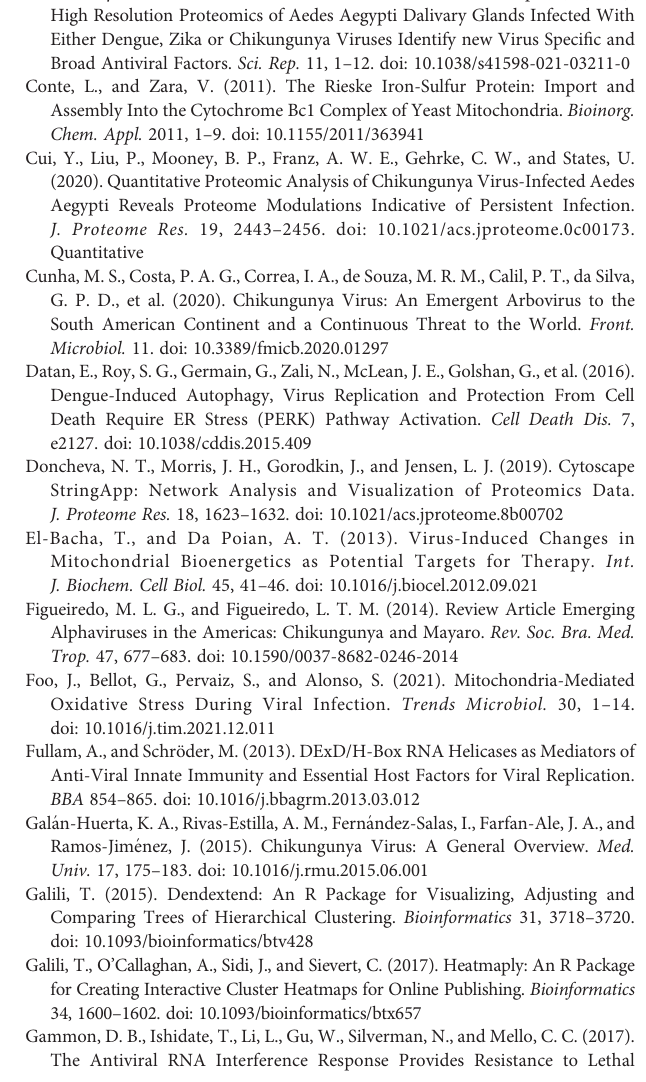
isolates. Vero cells are fi xed in culture and produce an extracellular matrix that is degraded after cell death. Then, cells become rounded. Supplementary Figure 2 | Quality control of protein group identi fi cation and quanti fi cation. (A) Boxplot of log 2 protein group abundances. (B) Histogram of log 2 protein groups abundances. (C) Number of valid values according to the number of replicates, cut-off of three replicates was used in this analysis, represented by the dashed line. (D) fi lter for ANOVA and g-test analysis, only ANOVA fi lter was used, set by two replicates per group, represented by the dashed line. (E) robust Mahalanobis distance analysis considering Correlation, median absolute deviation, skewness and proportion of missing values, suggesting the absence of extreme outliers (p-value = 1e-04). (F) probabilistic principal component analysis of protein group abundances according to each replicate. Supplementary Figure 3 | Bubble plot of enriched biological process GO terms in VSclust clusters. GO terms enrichment values are represented by colored circumferences. A clear predominance of translation GO terms can be seen in the enriched terms of Cluster 1, mainly in those with eneRatio